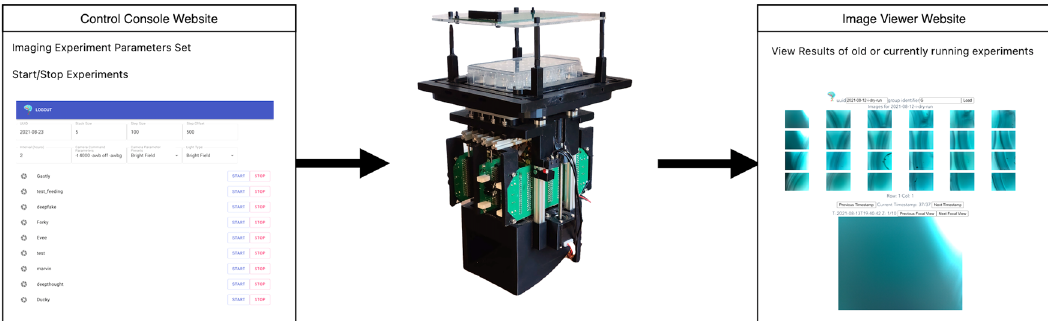
Fig. 2 Basic work fl ow from Control Console to Image Viewer. The Control Console passes commands and experiment parameters to Picroscope, which uploads results to a server allowing them to be viewed through the Image Viewer